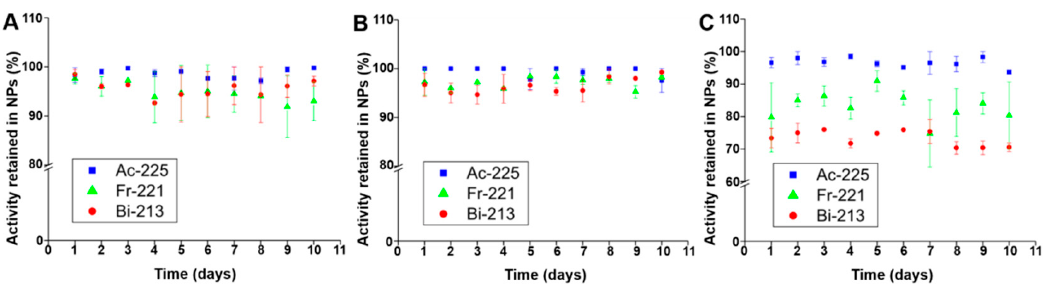
Figure 2. Stability studies of 225 Ac@Fe 3 O 4 nanoparticles in 0.9% NaCl ( A ), 1 mM phosphate-buffered saline (PBS) ( B ), and human serum ( C ).